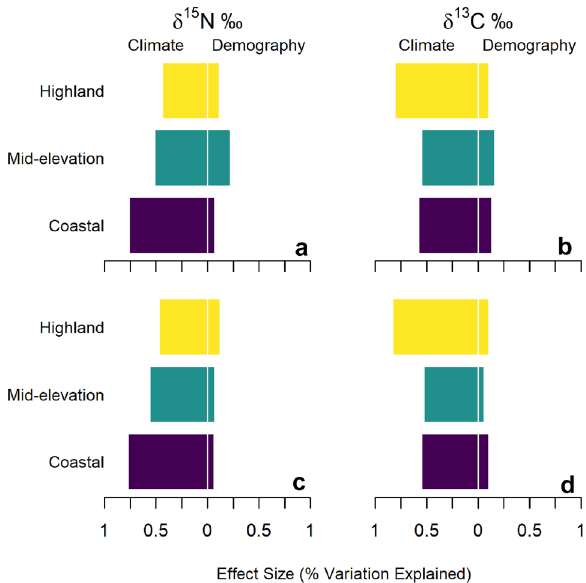
Figure 4. Cumulative climate and demographic effect sizes. Cumulative climate and demographic effect sizes (percent of the per mil amount of variation explained) within each elevation category for δ 15 N‰ (left column) and δ 13 C‰ (right column). ( a, b ) The cumulative effect sizes employing the uncorrected KDEs. ( c, d ) The cumulative effect sizes employing the taphonomically corrected KDEs. Regardless of KDE used for demographic estimates, climate change consistently has a larger effect than